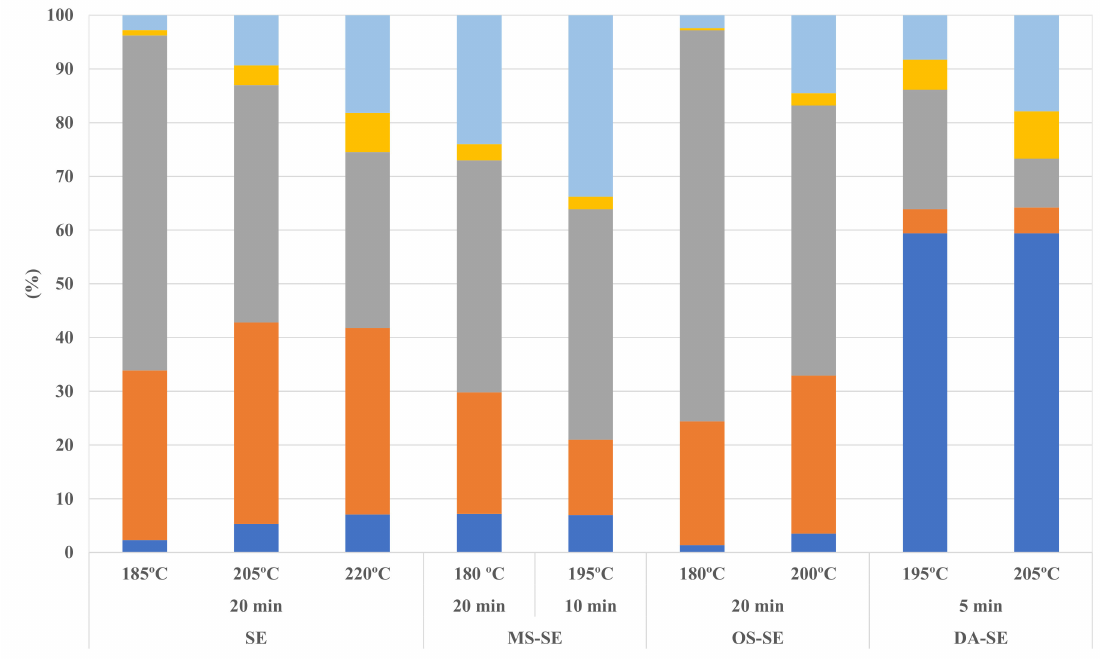
Figure 1. Xylan distribution in MFGW pretreated with SE, MS-SE, OS-SE, and DA-SE